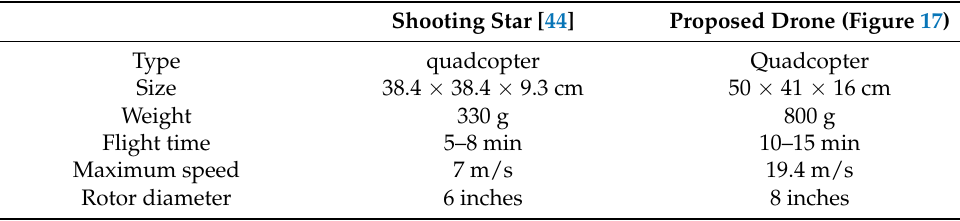
Figure 17. Swarming flight drones (left: deployed drones, right: swarming flight drone). Table 2. Performance comparison of the Intel Shooting Star and the proposed